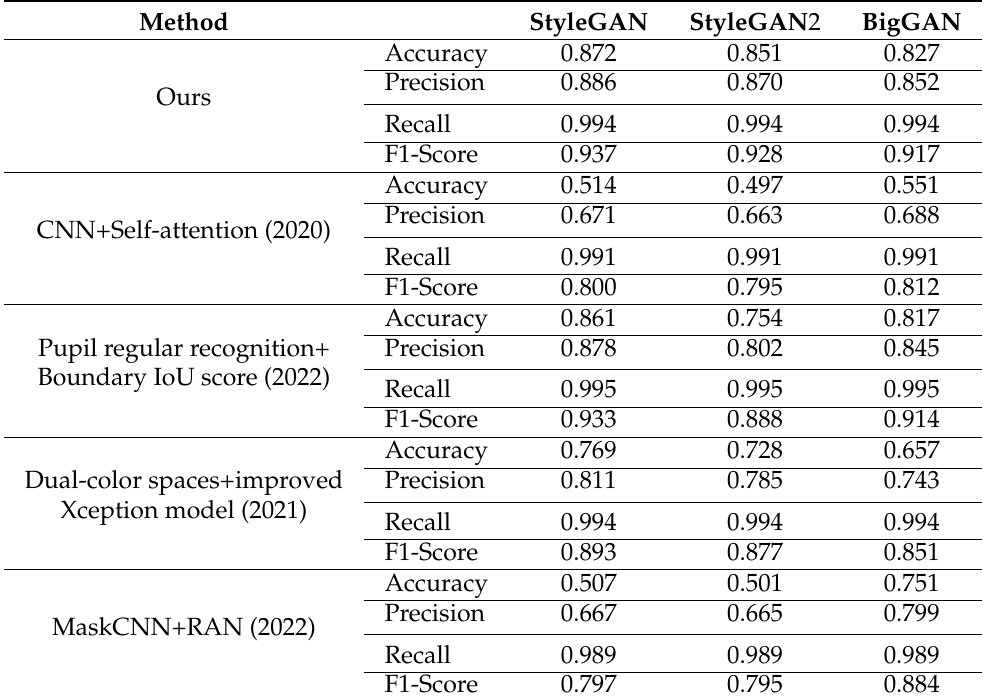
Table 3. Results 2.1: cross domain